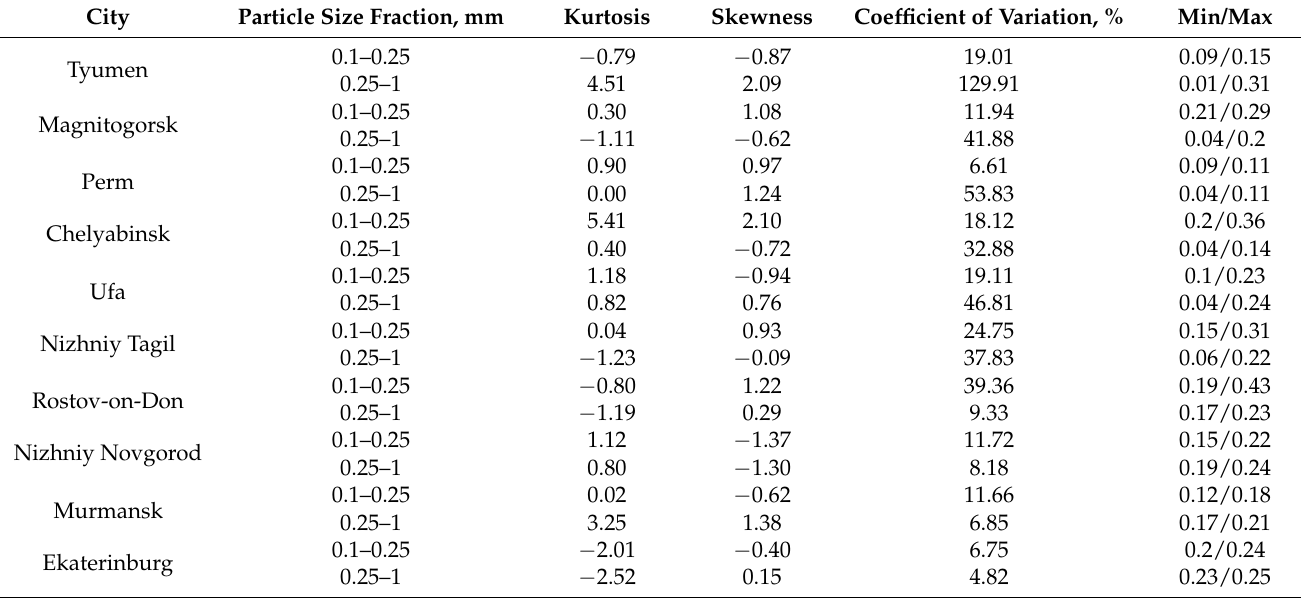
Table 3. The additional parameters of distribution of the proportion of technogenic particles in particle size fractions of 0.1–0.25 and 0.25–1 mm in cities.